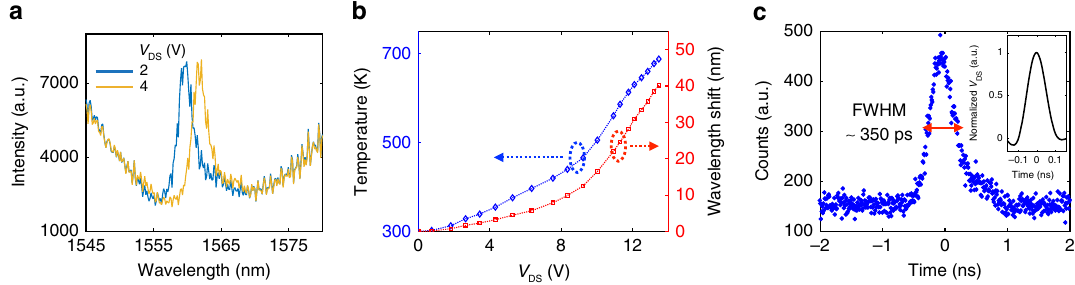
Fig. 4 PPC cavity temperature and time-dependent thermal emission. a The re fl ection spectra of the PPC cavity at applied V DS voltages 2 and 4 V on the graphene emitter. The cavity resonance shows constant red-shifting as V DS increases. b The wavelength shift (red) and the extracted temperature (blue) of the PPC cavity with respect to V DS . c Generation of a short (350 ps) thermal radiation pulses from the cavity-graphene emitter by applying an 100-ps electrical pulse. Inset: temporal pro fi le of the electrical